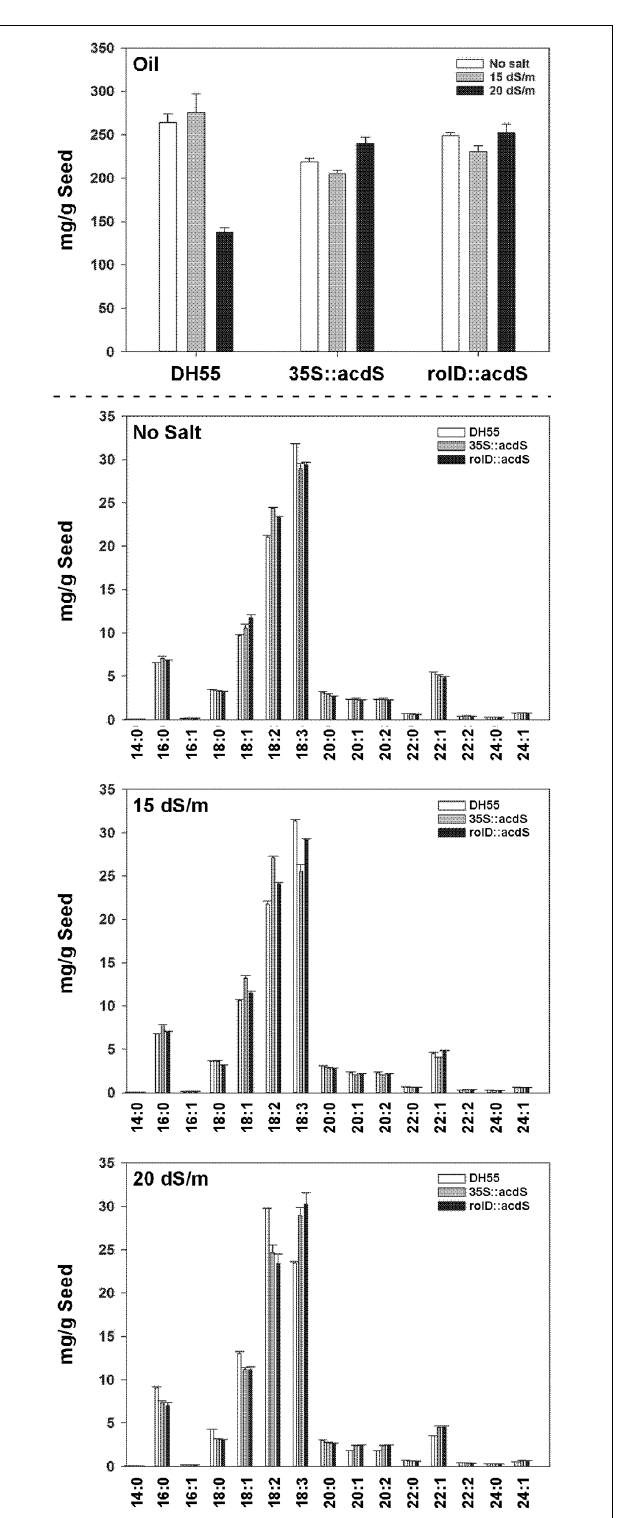
FIGURE 13 | The effect of acdS expression on seed oil and fatty acid content in camelina plants grown in the absence of, or presence of, salt (15 and 20 dSm − 1 ). Lines tested include wild-type C. sativa DH55 and